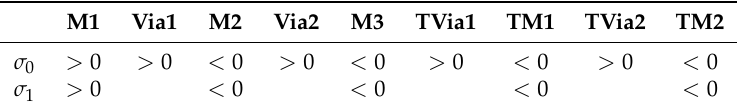
Table 5. Qualitative summary of observed stress ( σ 0 ) and stress gradient ( σ 1 ) for subsequent metal and via